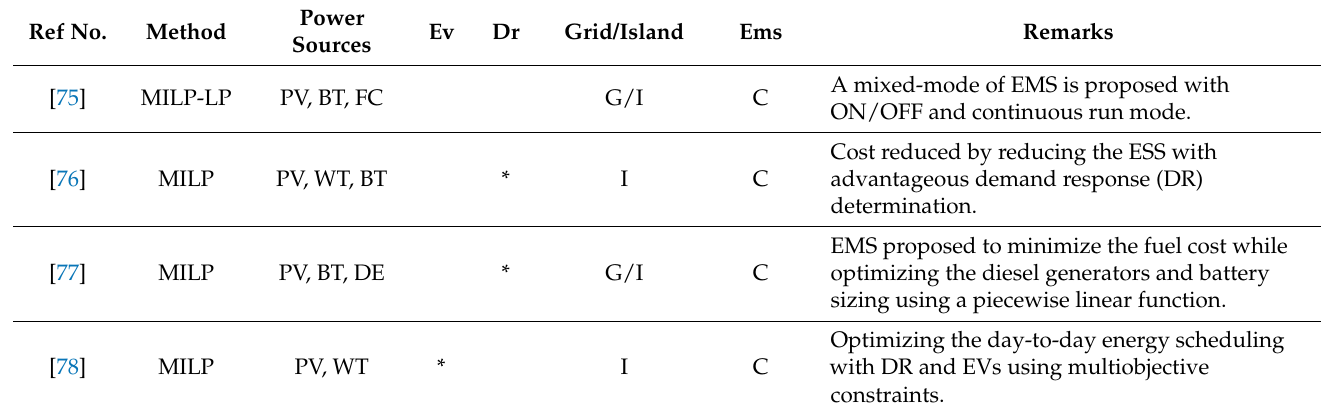
Table 5. A review on classical mathematical programming methods used in EMS. Ref